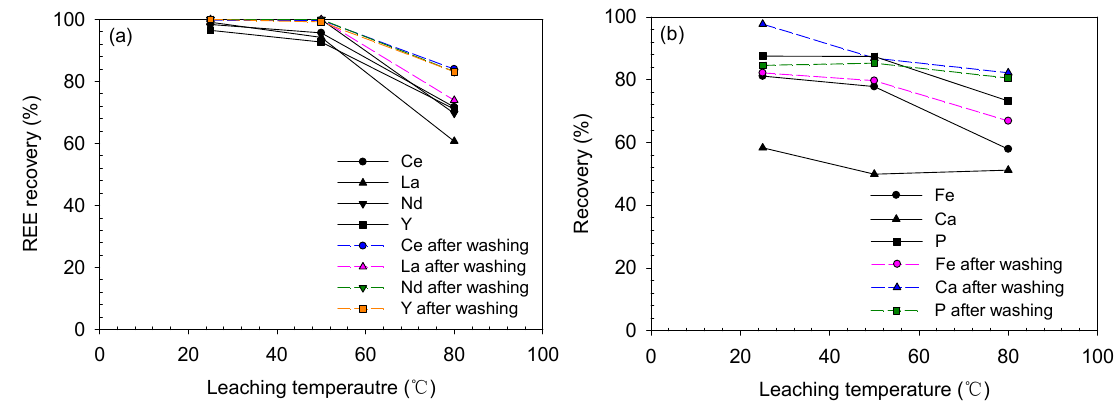
Figure 11. Leaching recoveries of ( a ) REEs and ( b ) impurities after water-leaching of the baked ore at 25–80 °C for 3 h (baked at 2.0 acid/solid ratio and 200 °C for 2 h) . Table 4. Solubilities of Ca sulfate and REE sulfate compounds at 25, 50 and 80 °C (the numbers inside the parentheses are the solubility of Ca and REEs) .